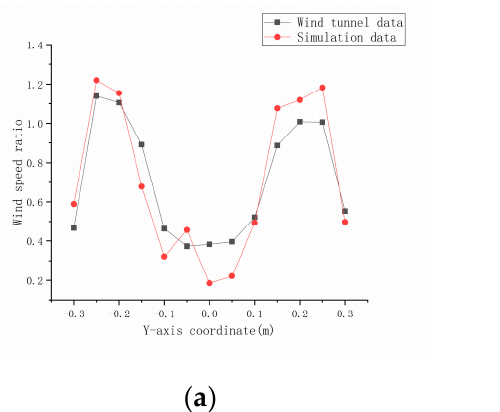
Figure 1. Wind tunnel model and schematic diagram of measuring points.( a ) A wind tunnel exper- imental physical model. ( b ) Measuring point azimuth diagram.